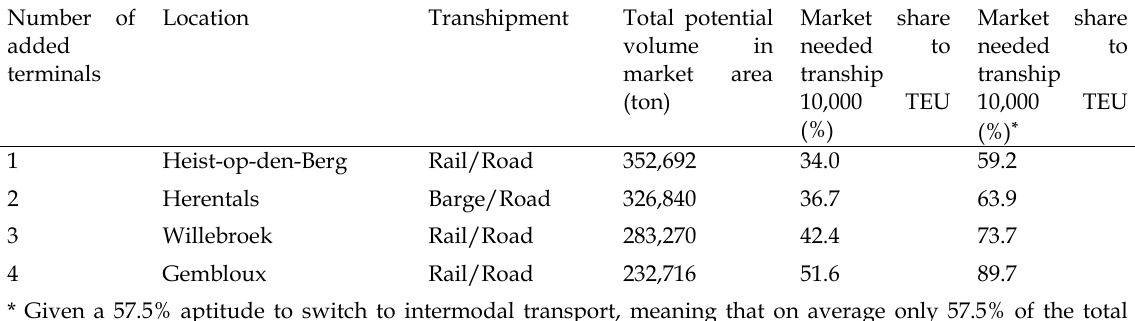
Table 2. Additional terminals and their estimated market potential (incl.